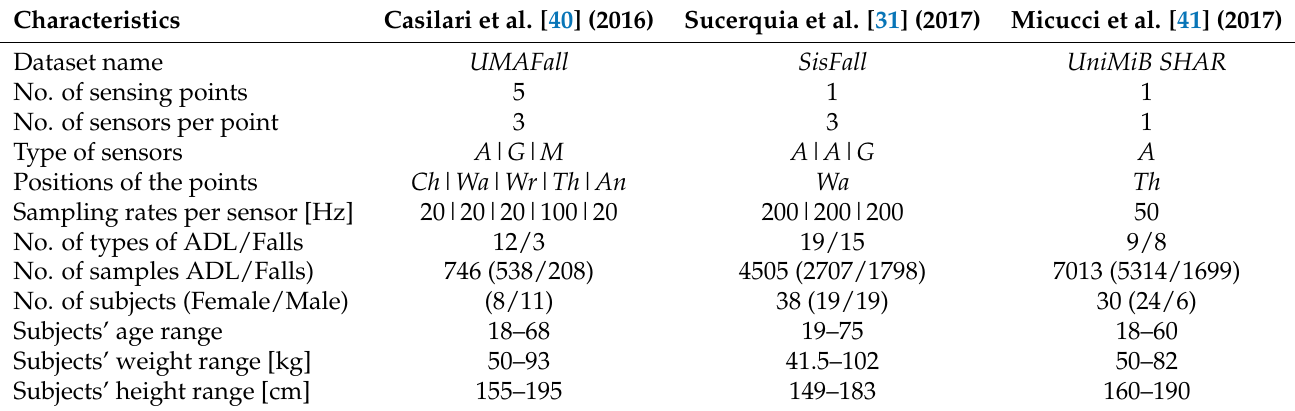
Table 2. Main characteristics of the considered datasets. Adapted from